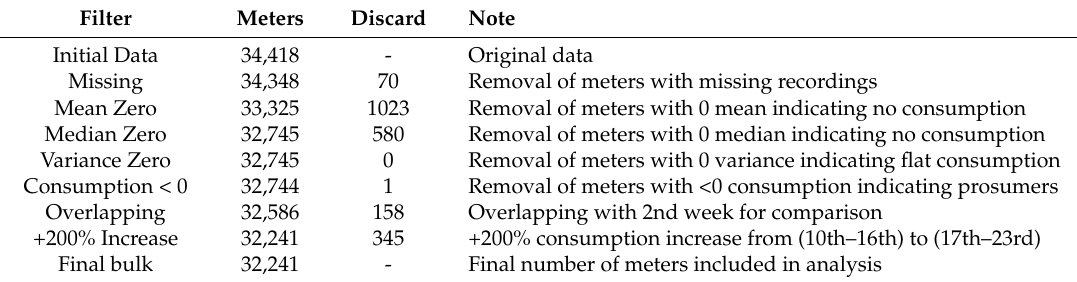
Table 2. Data cleaning waterfall. Filter indicates the removal criteria and Meters show the remaining meters after the application of the filter. Discard is the number of meters discarded through the filtering. Final bulk is the number of meters ready for analysis after the cleaning of data.